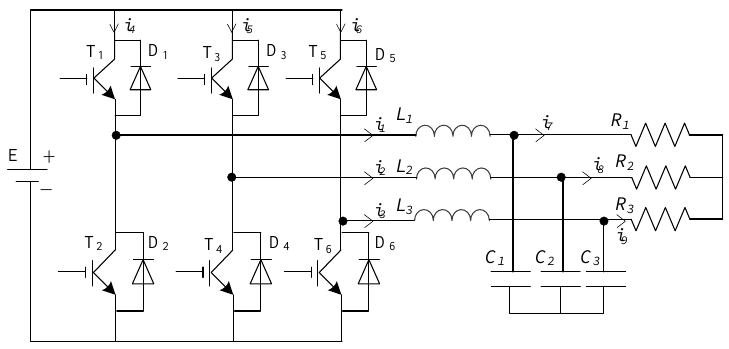
Figure 2. Three-phase inverter with LC filter.